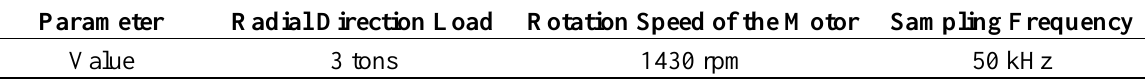
Table 4. Parameters of the first experiment.